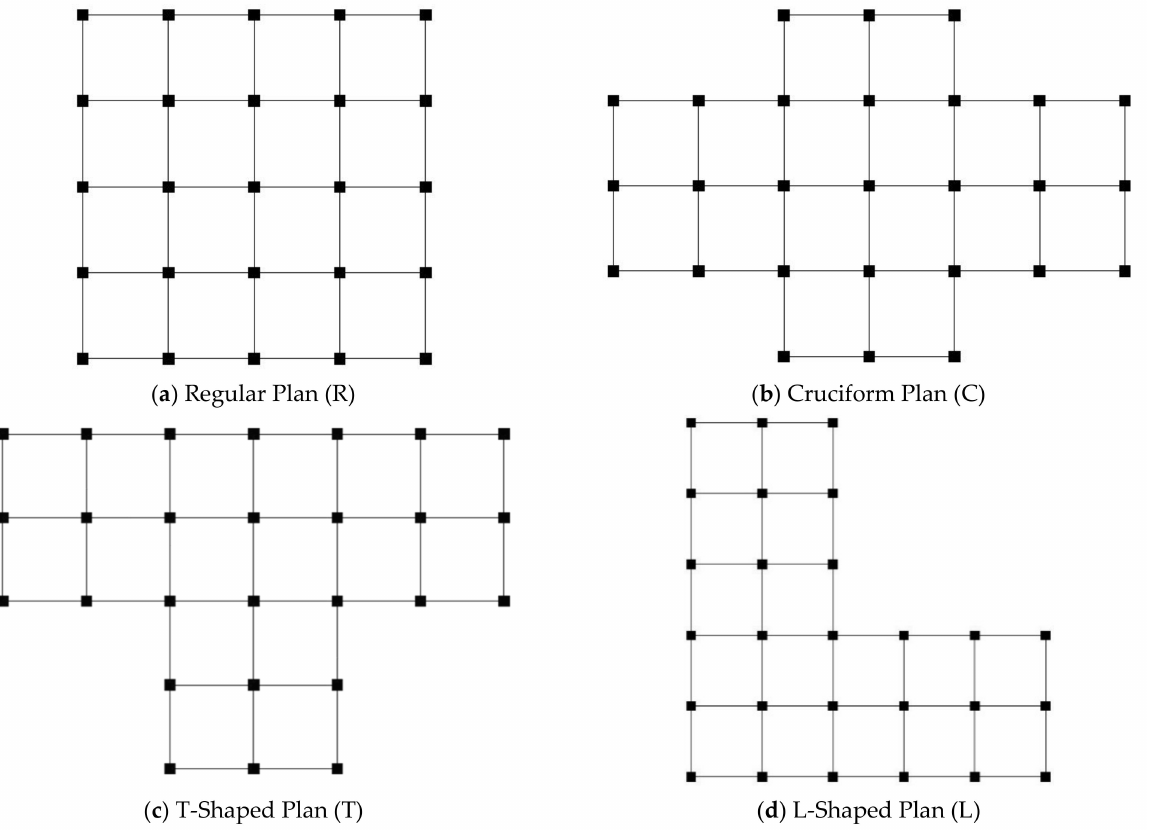
Figure 3. The building